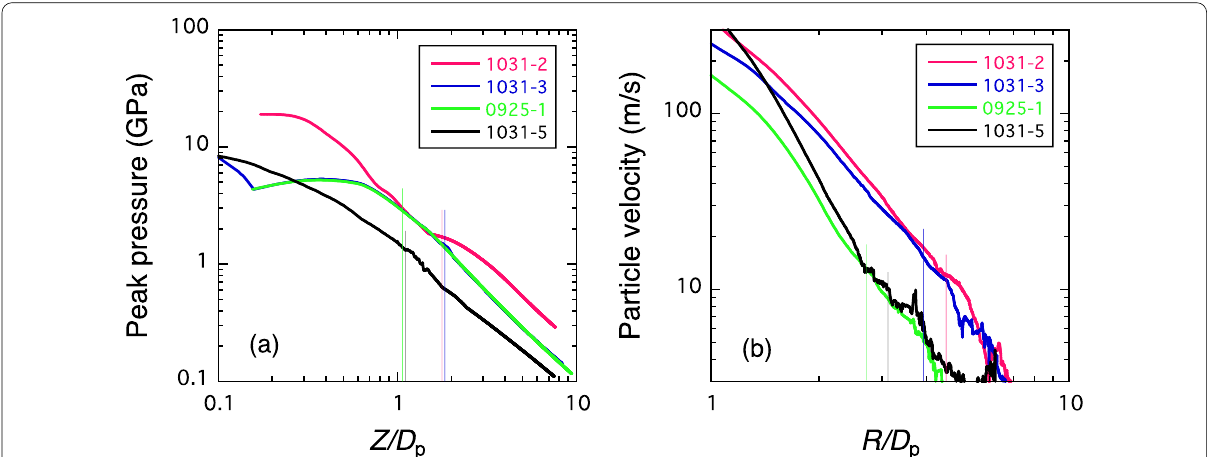
Fig. 8 Profiles of a peak pressure and b particle velocity along the central axis and the target surface, respectively, for the results shown in Fig. 7. The peak pressure profiles for 1031-3 (the closed tube impact at open side) and 0925-1 (open tube) are similar and hence almost overlap. The experimental results of crater depth and crater radius are indicated as vertical lines (the line and profile with the same color are corresponding)